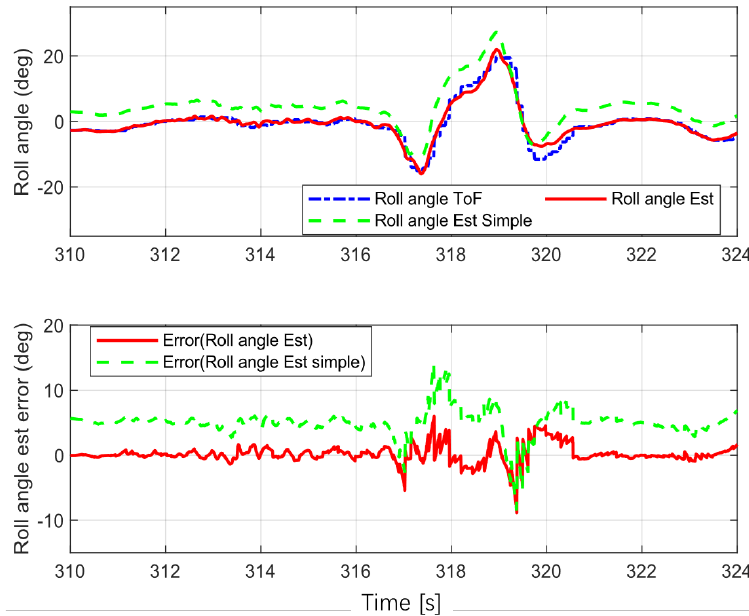
Figure 8. Double lane change.